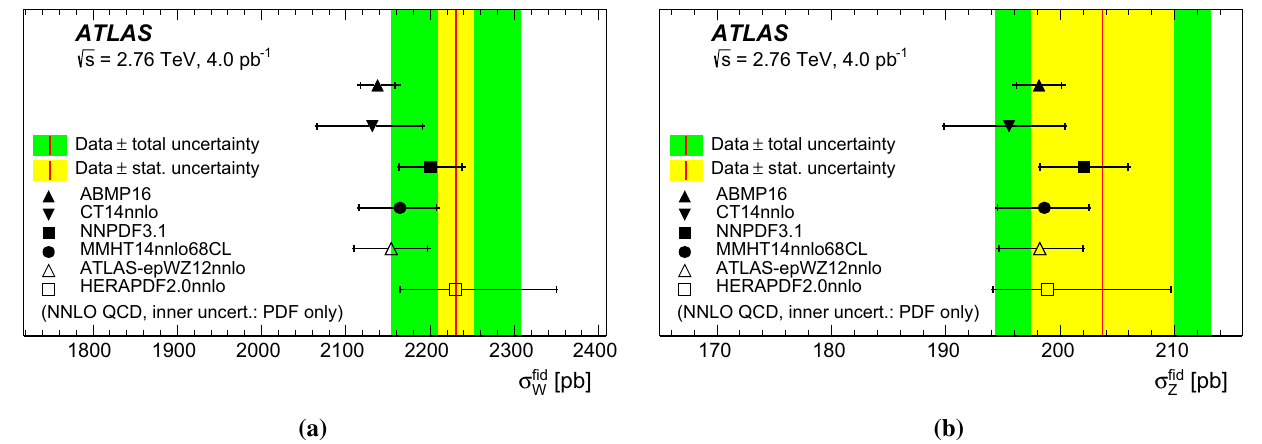
Fig. 6 NNLO predictions for the fiducial cross-sections (a) σ fid and (b) σ fid for the six PDFs CT14nnlo, MMHT2014, NNPDF3.1, Z ATLASepWZ12, ABMP16 and HERApdf2.0 compared with the mea- sured fiducial cross-section as given in Table 7. The inner shaded band